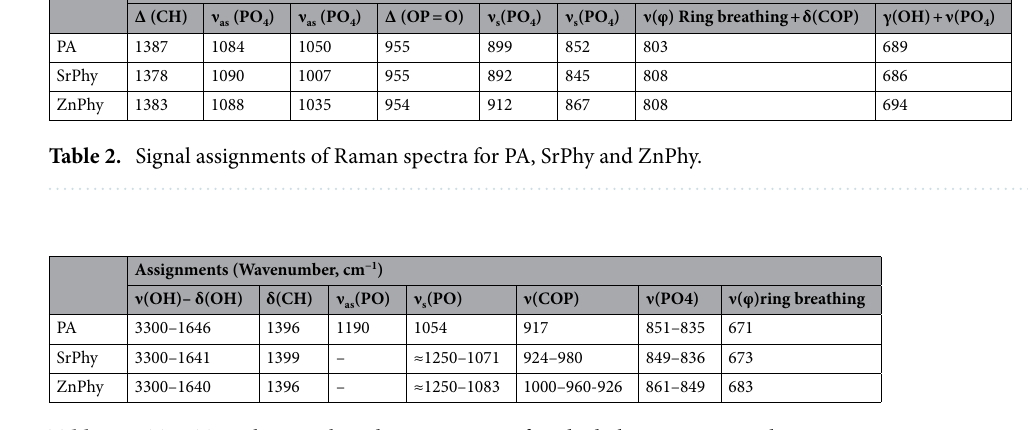
Table 3. ATR-FTIR vibrational mode assignments of studied phytate compounds.